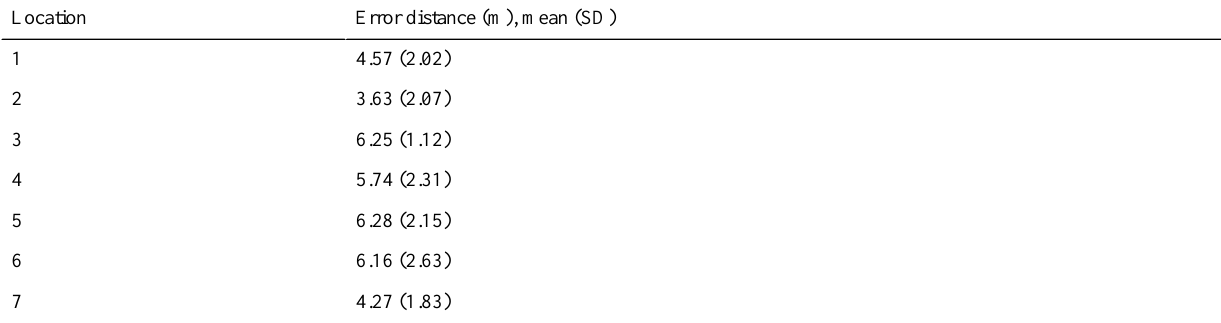
Table 3. Average distance errors and standard deviations for the EDIPS testing